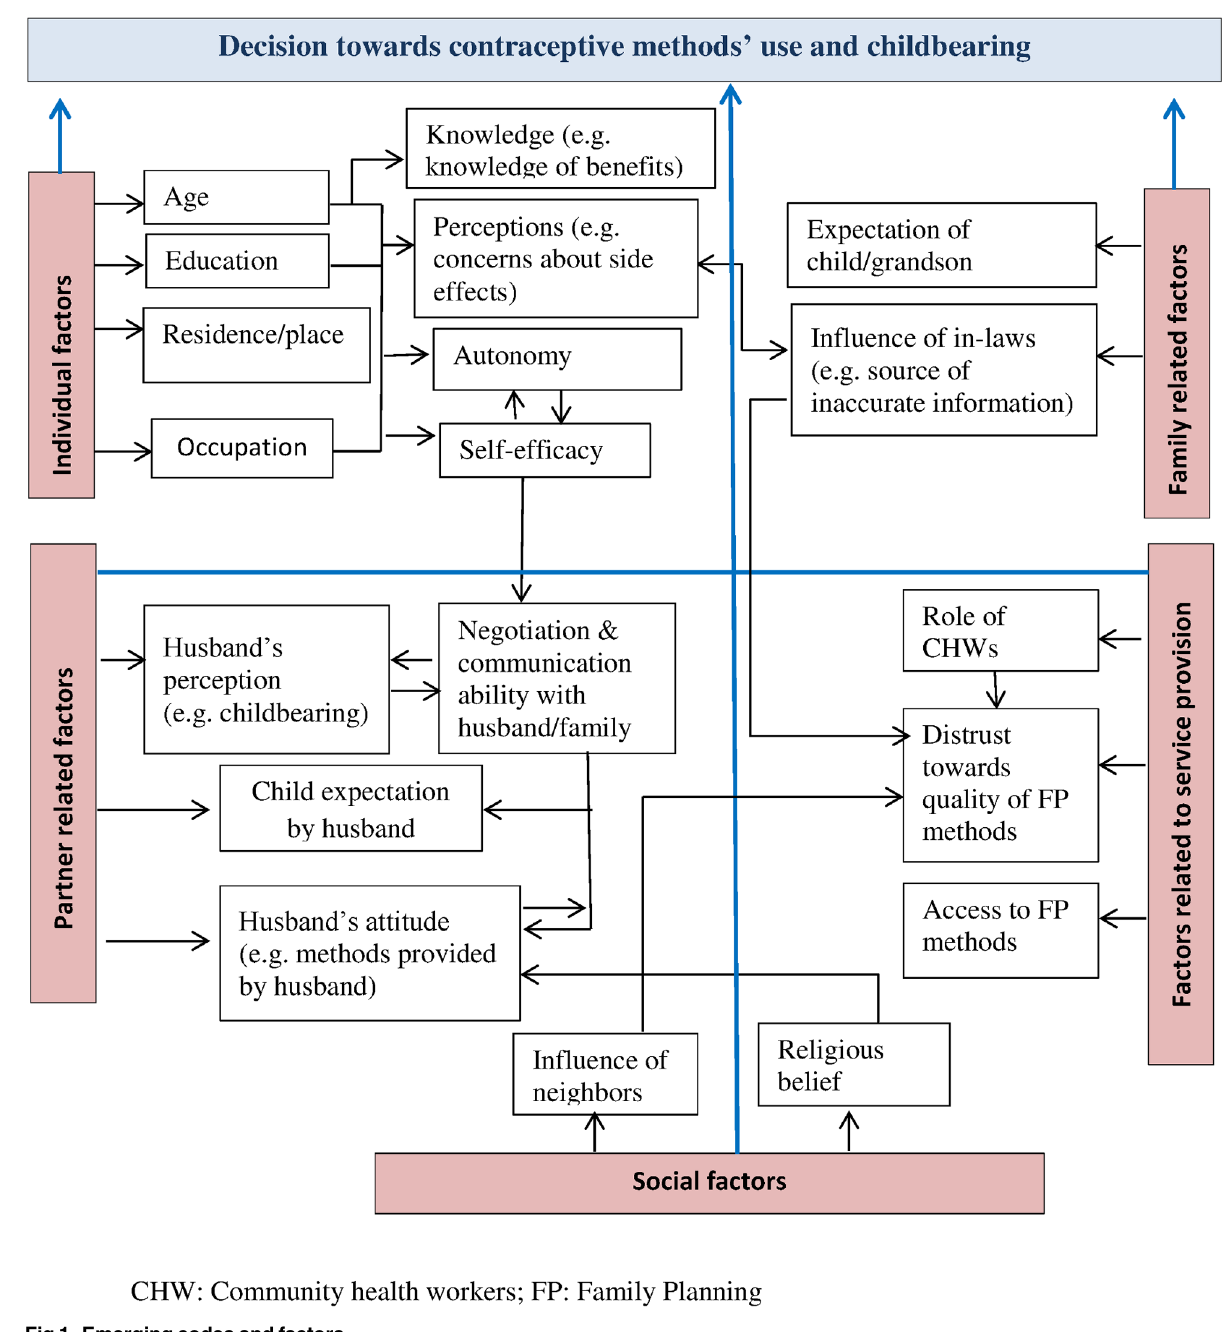
Fig 1. Emerging codes and